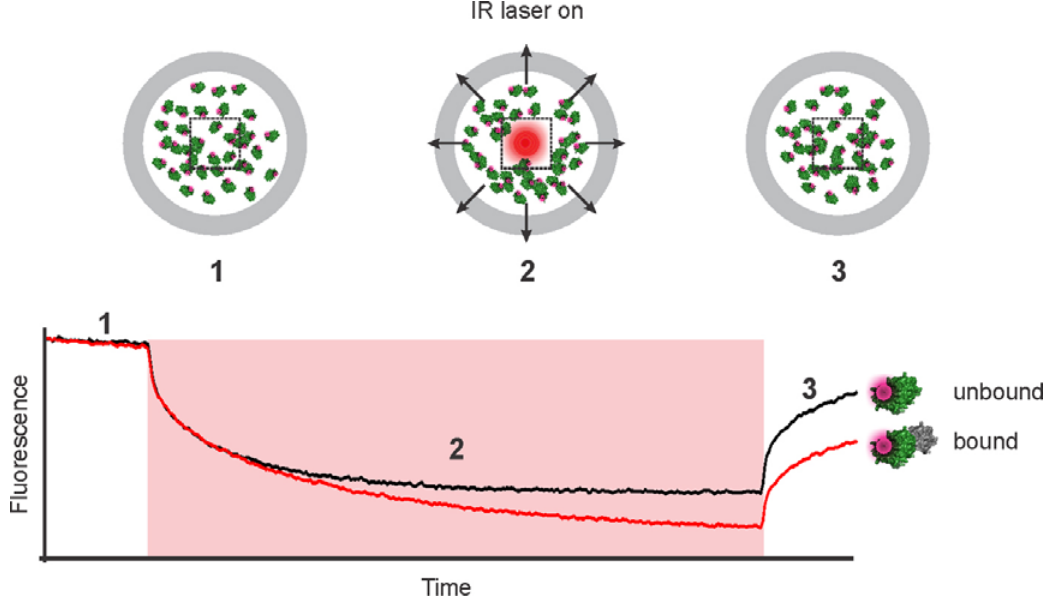
Figure 5. The MST experiment. The solution of molecules (green with magenta dots) is applied to the capillaries (grey circles). Following the ini- tial fluorescence excitation of small fraction of the sample (dashed square) (1), the same part of the capillary is heated with IR laser (2). Upon hea- ting, molecules usually drift away from the heating spot. The drift is observed as a reduction of the fluorescence. After turning the IR laser off, the back-diffusion of the molecules happens and this is detected as an increase of fluorescence (3). The bound and unbound molecules diffuse diffe- rently in the thermal